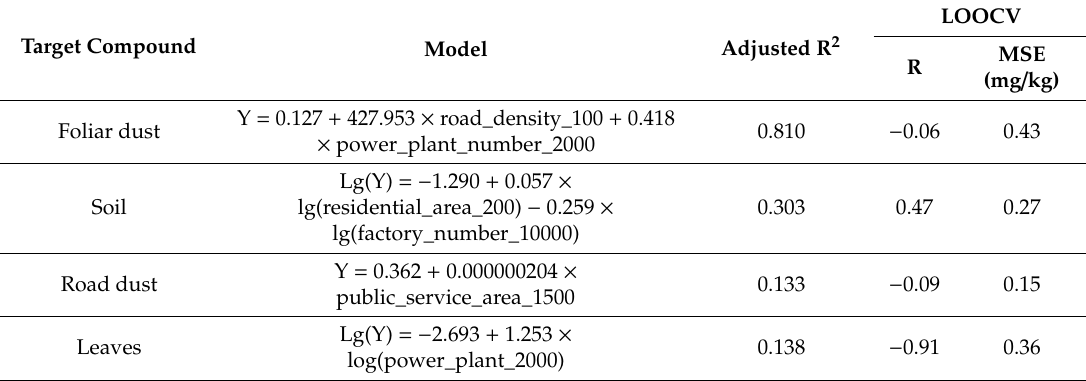
Table 5. Land use regression model for mercury in foliar dust, soil, road dust, and leave. Target